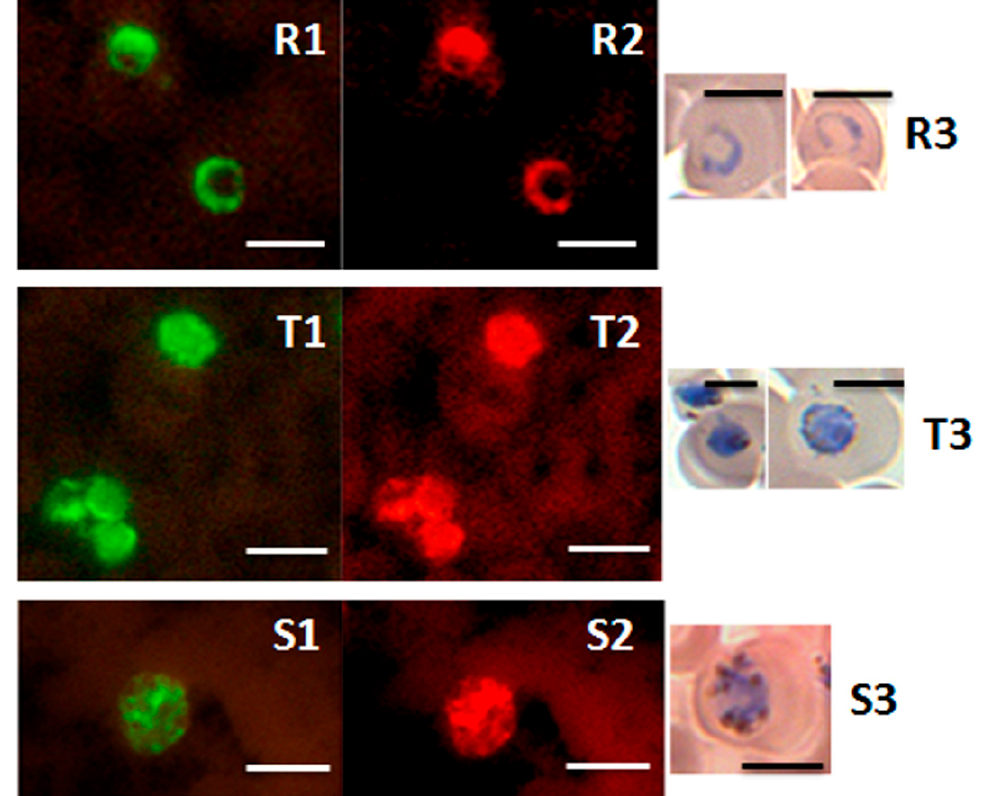
Figure 5. Detection of ring, trophozoite and schizont stages of P. knowlesi in the PK-FISH test. Photographs showing results from the PK-FISH test with the P. knowlesi -specific probe (green fluores- cence) and the Plasmodium genus-specific probe (orange fluorescence) on R—rings; T—trophozoites; S—schizonts. Dual colour fluorescence in the same field is shown in paired photographs R1 and R2 , T1 and T2 , and S1 and S2 . Fluorescence was viewed in a LED fluorescence microscope with pertinent light filters (Figure S1) . The ring, trophozoite and schizont-stage parasites were produced from synchronised in vitro cultures of P. knowlesi . Parasites stained with Giemsa from smears pre- pared in parallel to the corresponding smears used in the PK-FISH test are shown in R3 , T3 and S3 respectively. The scale bars represent approximately 5 µ m. Reproduced with permission under the creative commons license from Reference